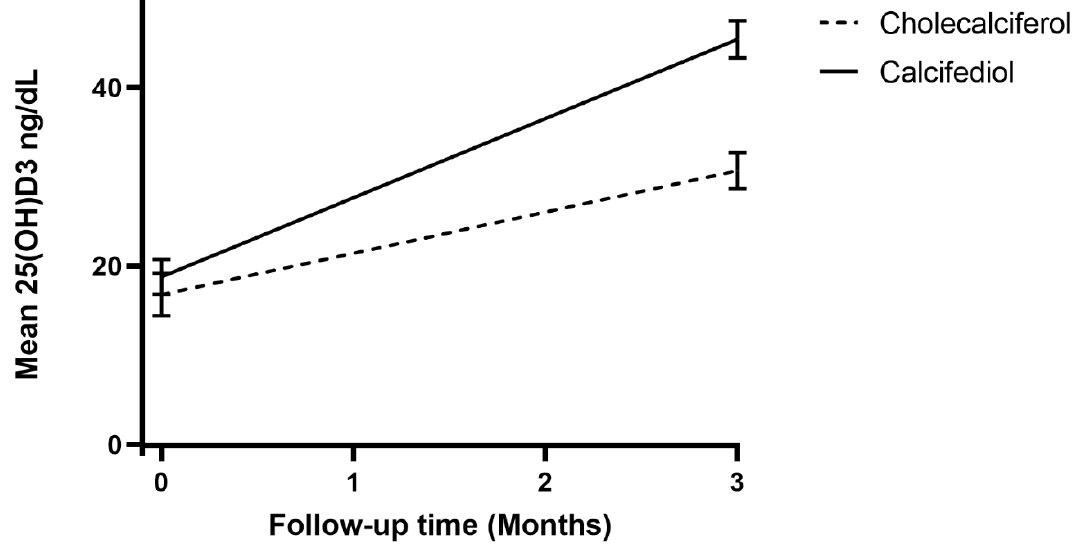
Figure 2. Mean 25OH-vitamin D3 values over time, according to the type of vitamin D supplemen- tation.